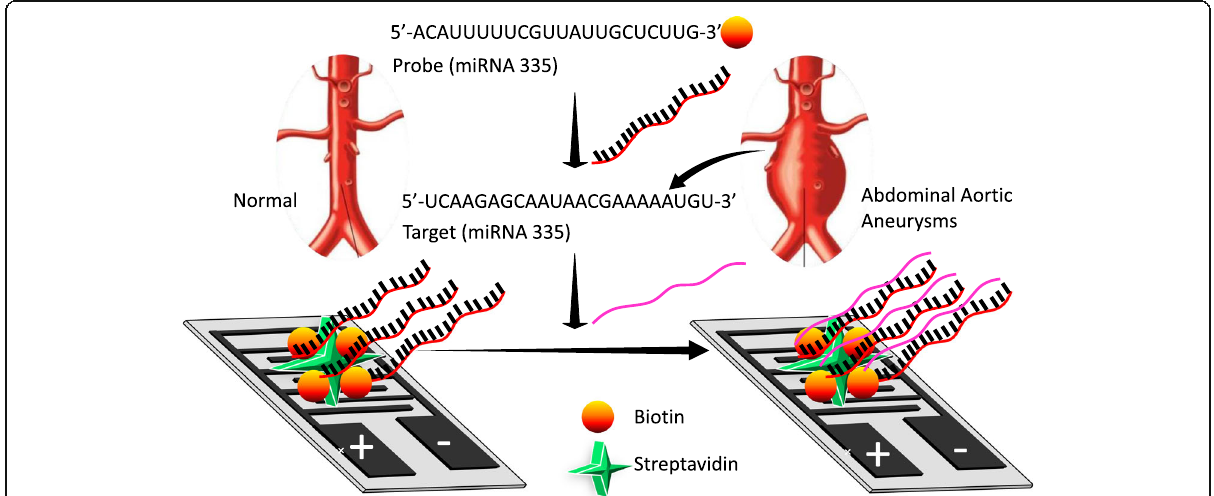
Fig. 1 Representation of the detection of miRNA-335-5p on an IDE. The designed probe and target are shown along with the duplex formation on the IDE surface